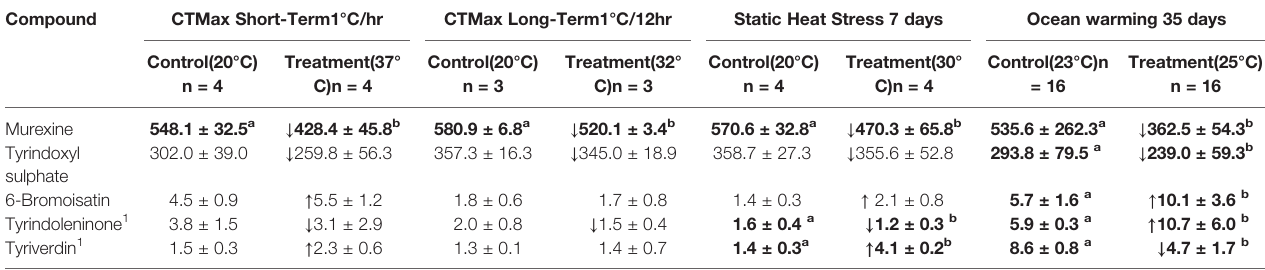
TABLE 3 | Mean ( ± SD) weight of precursor compounds (mg/g) extracted from the hypobranchial gland of D. orbita exposed to heat treatment compared to ambient controls in four separate experiments (see Table 1 ). Compound CTMax